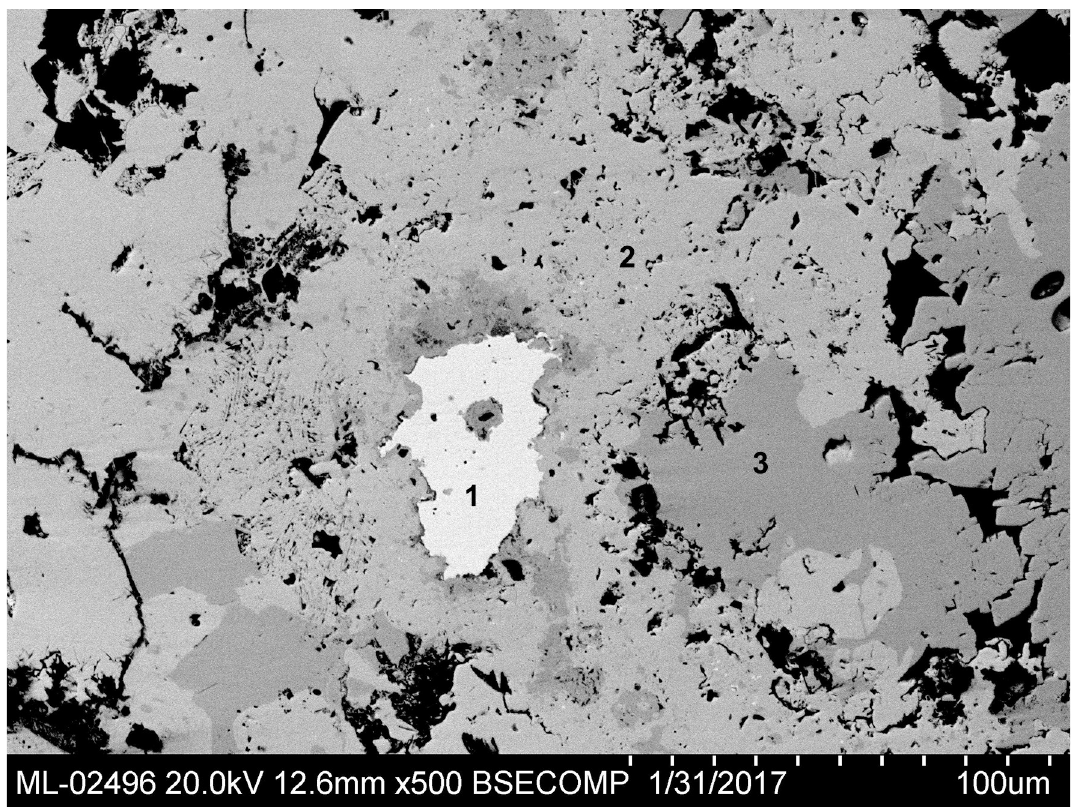
Fig 16. Lead sulphide inclusion in the lump Bleje ş ti 1–2. 1 galena, 2 litharge, 3 anglesite. SEM image, backscattered electrons (S. Rovira).